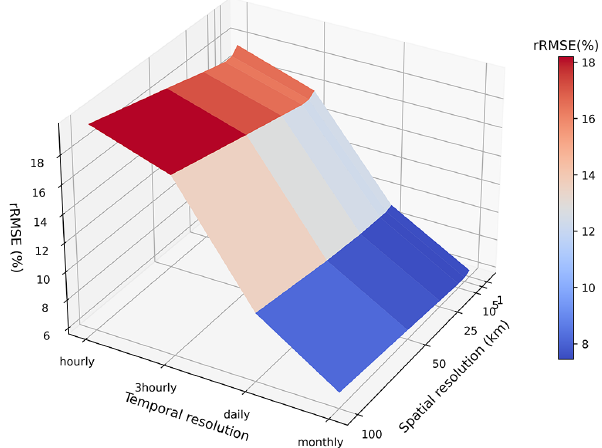
Figure 11. Influence of spatial and temporal resolution on DSR